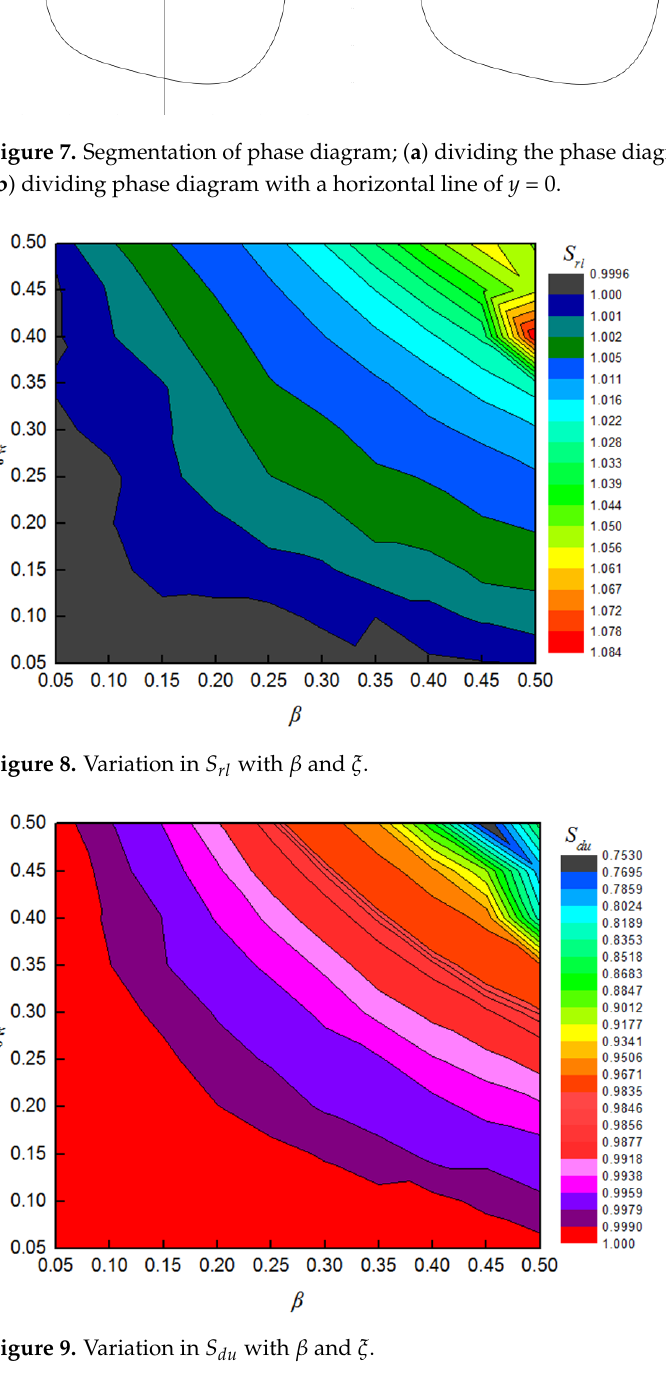
Figure 7. Segmentation of phase diagram; ( a ) dividing the phase diagram with a vertical line of x = 0, ( b ) dividing phase diagram with a horizontal line of y = 0.